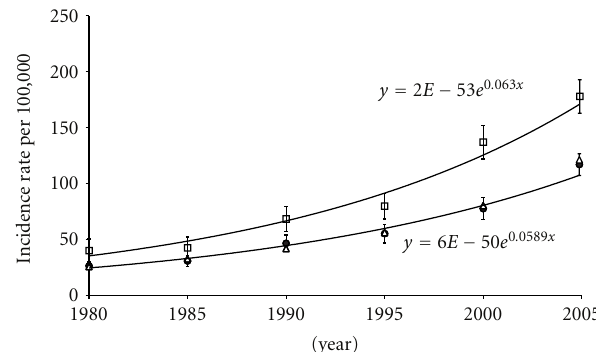
Figure 2: Evolution of Log transformed prostate cancer incidence rates expressed as ASRs for Martinique and metropolitan France. Incidence rates in Martinique are continuously at a higher level than in metropolitan France ( P < 0 .